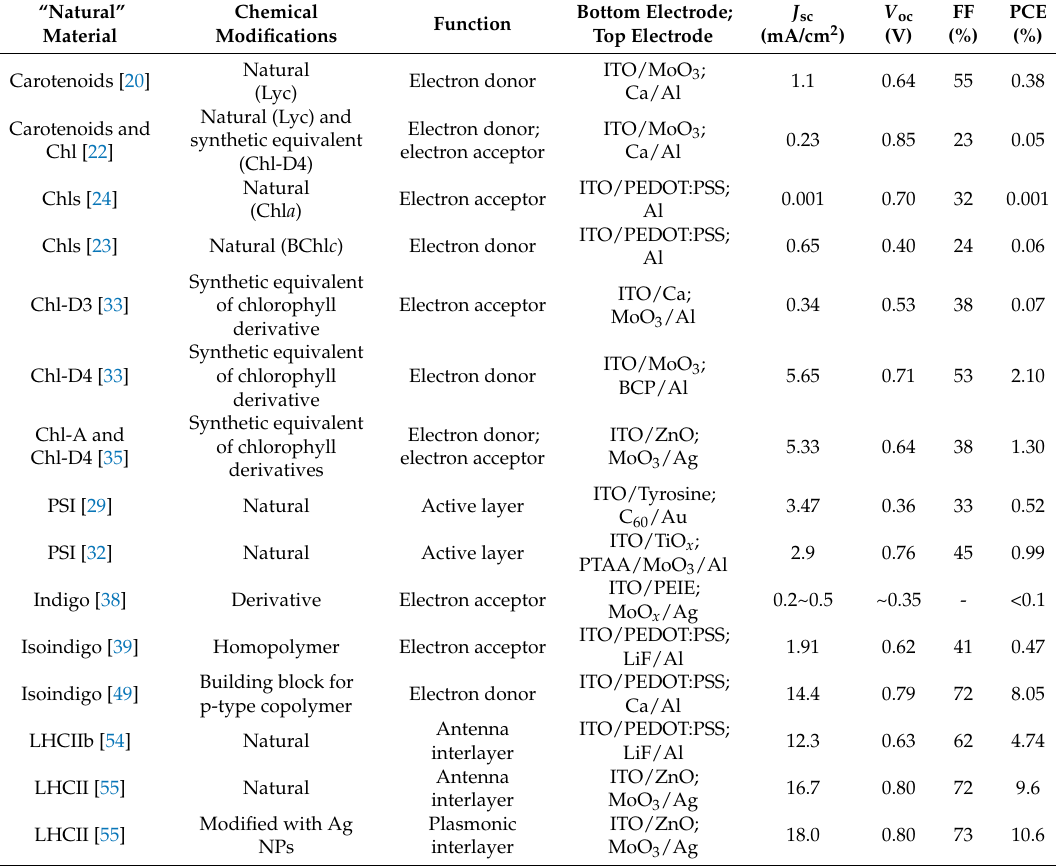
Table 1. Typical functional devices performances with the various strategies based on natural dye or natural dye derivative presented in this